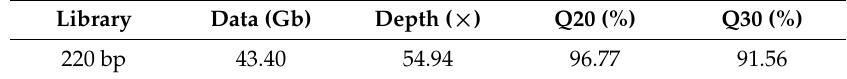
Table 1. Statistics of Luffa cylindrica L. sequencing data.